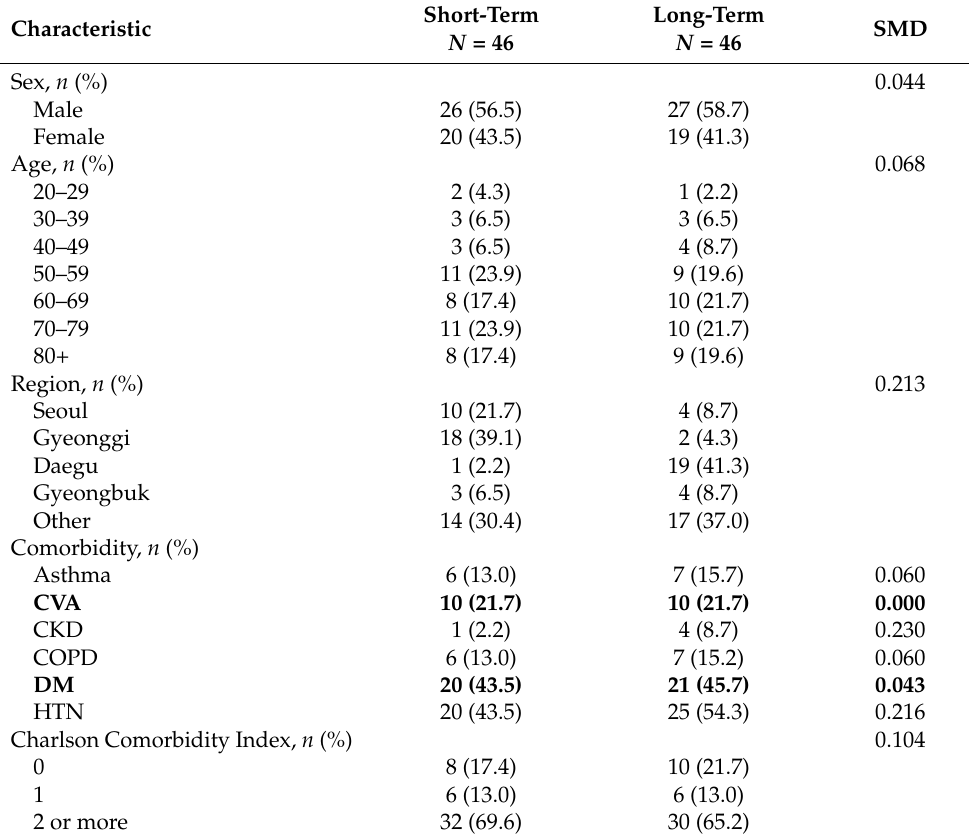
Table 2. Propensity score-matched baseline characteristics and positive COVID-19 test result between the short- and long-term NSAIDs-use